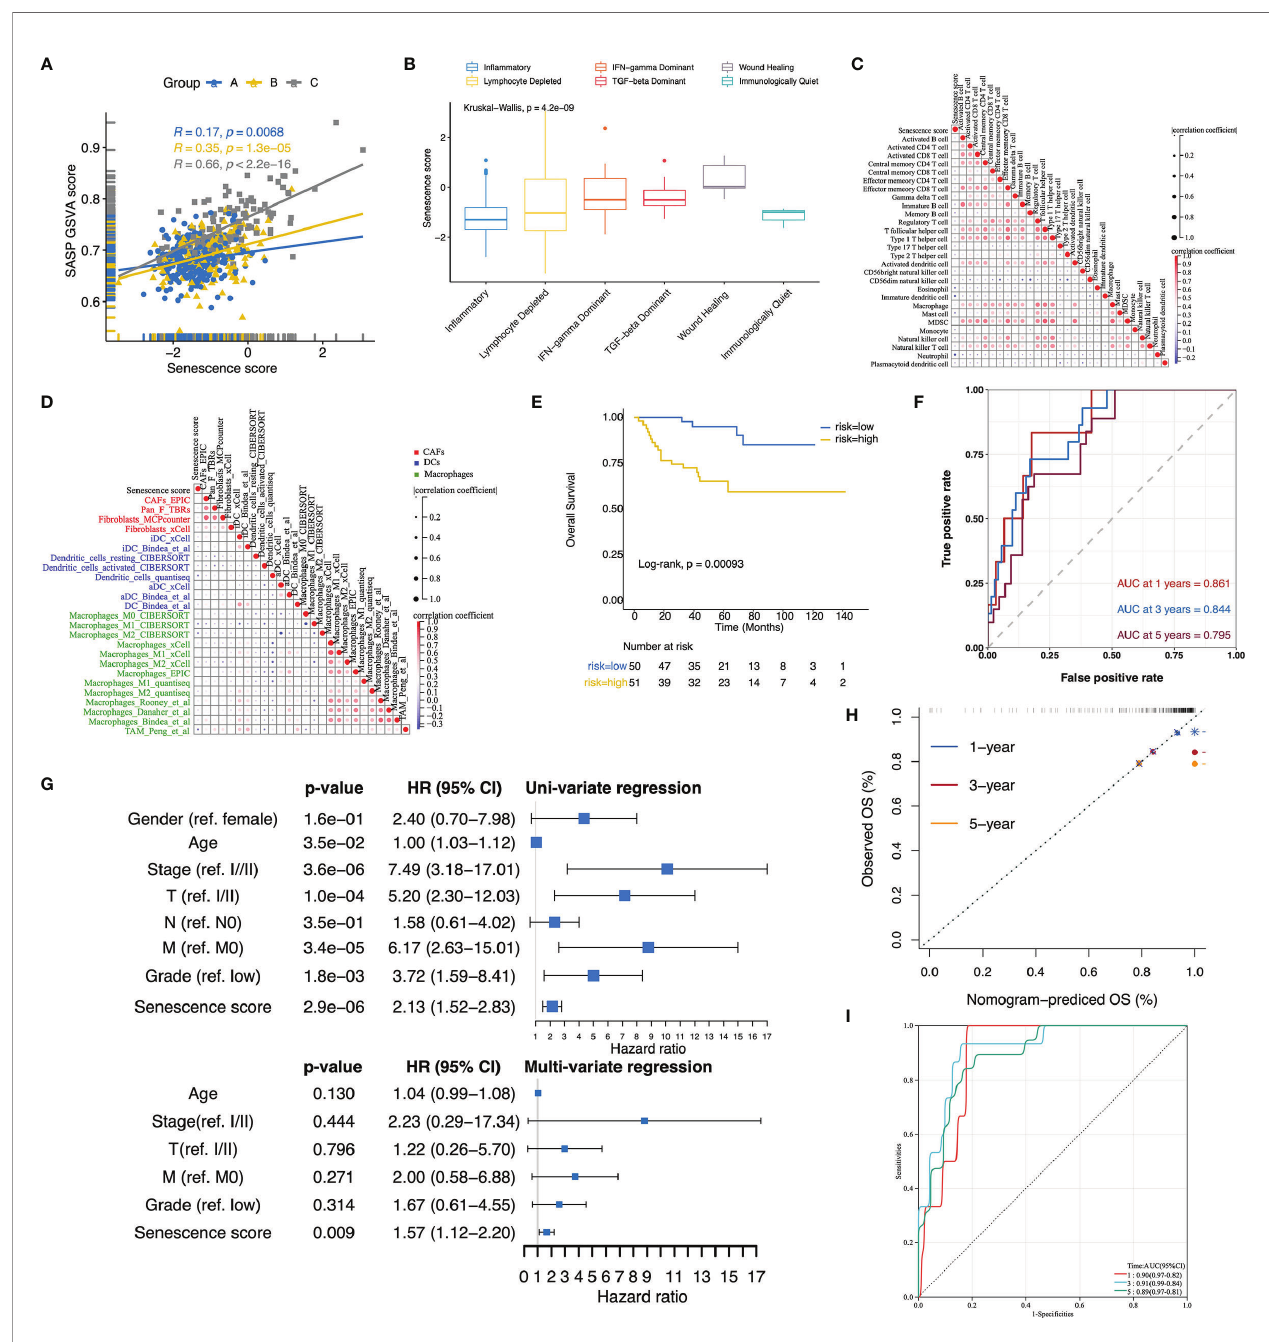
FIGURE 5 | Validation of the senescence score and nomogram to predict patients ’ overall survival in E-MTAB-1980. (A) Scatterplot with regression lines for senescence score with SASP activity strati fi ed by senescence subtypes. (B) The boxplot displayed that the senescence score was differentially distributed among immune subtypes. (C, D) Correlation plots displayed a negative correlation of the senescence score with in fi ltrated immune cells (C) , CAFs, DCs, and macrophage signatures (D) . The correlation was evaluated using Pearson ’ s correlation coef fi cients. (E) In E-MTAB-1980, the Kaplan – Meier curves revealed a different survival portion between the high- and low-senescence score subgroups. (F) ROC curve assessed the predictive power of the senescence score for 1-, 3-, and 5- year overall survival in E-MTAB-1980. (G) Forest plots of the uni- and multivariate Cox models in E-MTAB-1980. (H) The calibration curves showed that the survival status of patients predicted by the nomogram applied to E-MTAB1980 at 1, 3, and 5 years remains highly consistent with that actually observed. (I) ROC curves to evaluate the predictive ef fi cacy of the nomogram for overall patient survival at 1, 3, and 5 years in